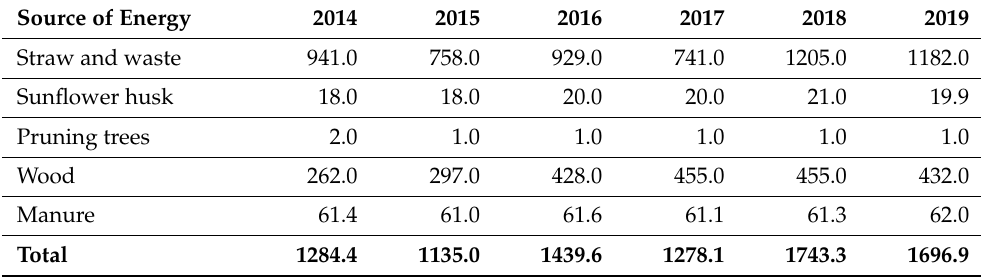
Table 5. The economic energy potential of waste in the Kyiv region, thousand toe. Source of